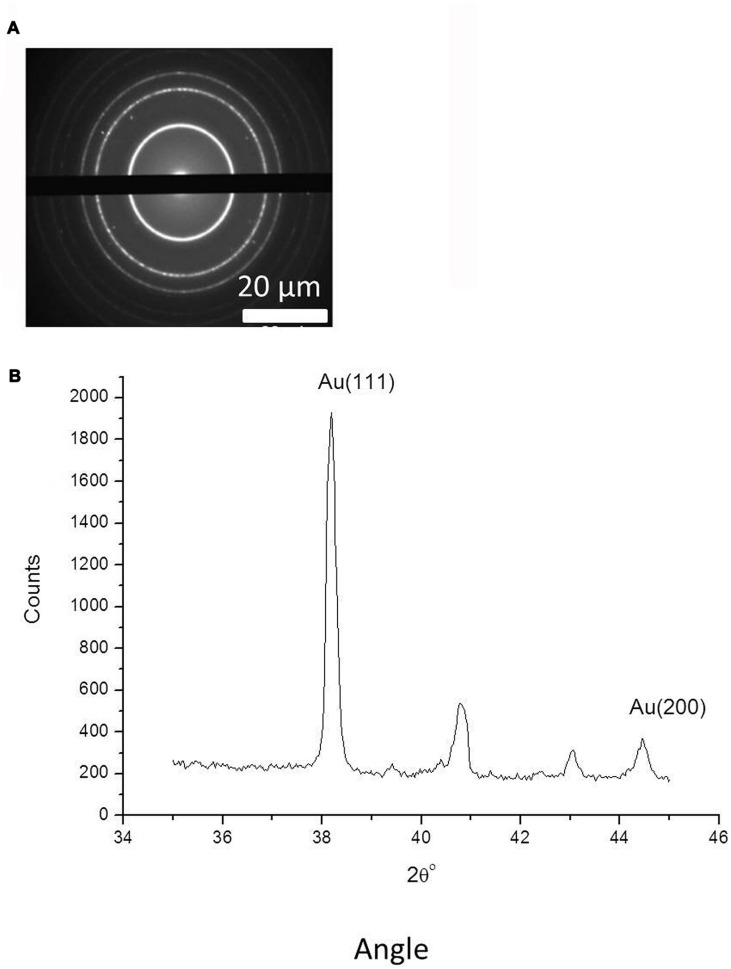
(A) Selected area electron diffraction analysis (SAED) analysis of gold nanoparticles, complete with scale bars. (B) Powder X-ray diffraction for gold nanoparticles measured in the 2Θ range from 35 to 45°, with indicated 111 and 200 peaks for metallic gold (JCPDS No. 04-0784).